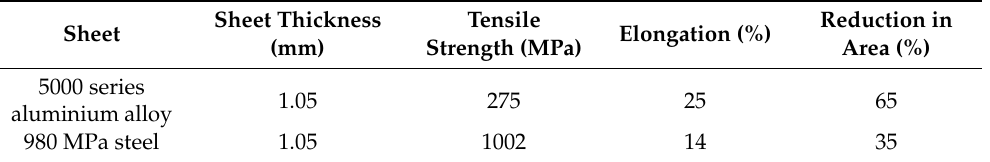
Table 1. Material properties of